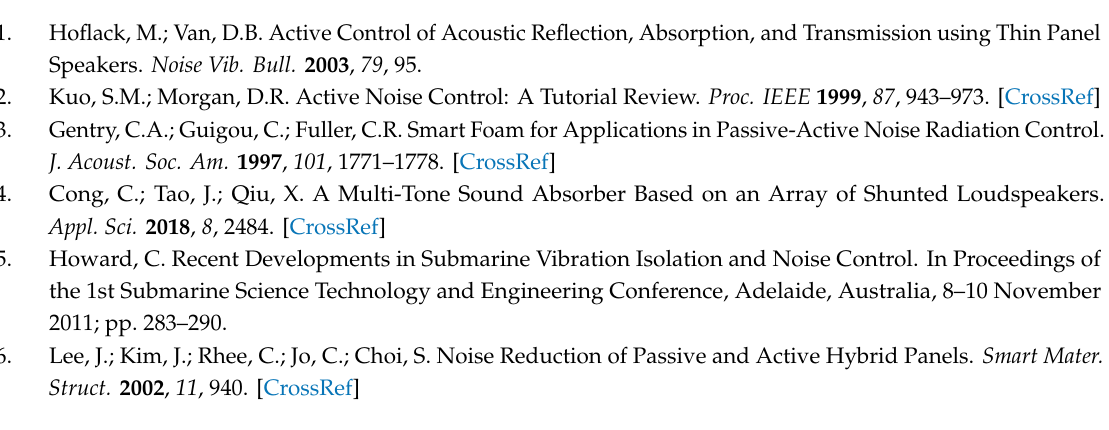
Figure 16. Adaptive control for a change of frequency: ( a ) a continuous input signal and ( b ) the echo reduction rate and system control parameter. reduction rate and system control